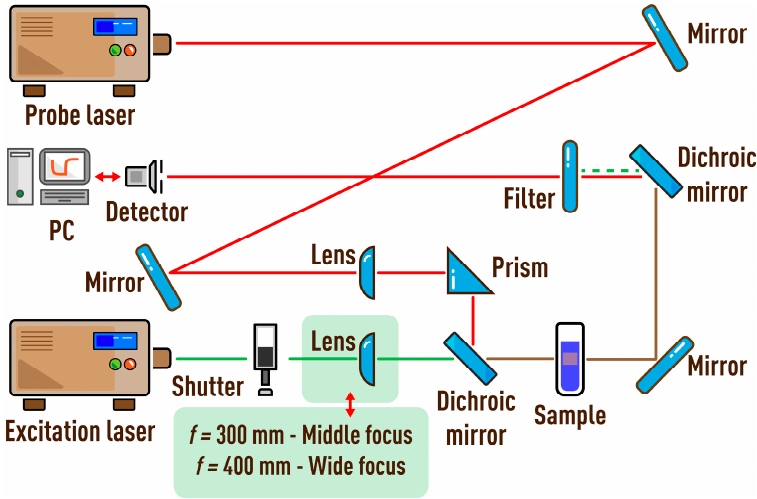
Figure 2. Schematics of middle-focused and wide-focused configurations of the thermal-lens spec- trometer.